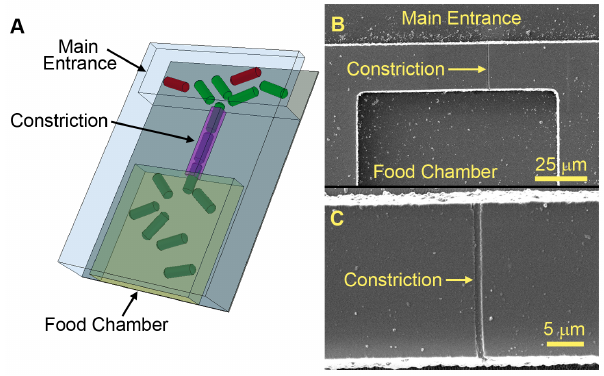
Figure 1. Automated isolation of pure bacterial cultures from the environment. (a) Schematic of one microfluidic device showing part of a single food chambers. The constriction geometry can be varied to isolate species with particular physical characteristics. (b) Scanning electron microscope image of one food chamber that is connected to the outside environment with a sub-micrometer constriction. (c) Magnified image of the constriction shown in (b). (b–c) White particles seen on the SEM images formed during the metal sputtering step of SEM sample preparation. Freshly made polymer chips do not have visible particles on the